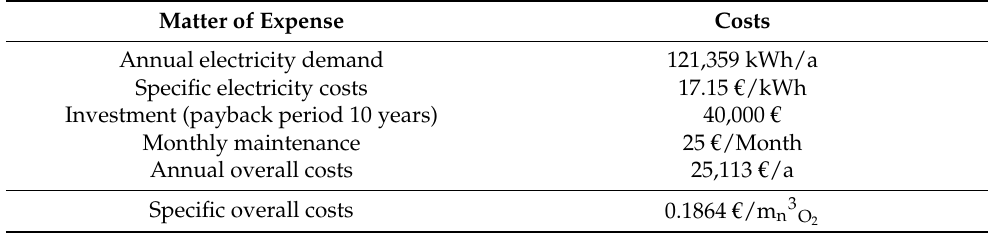
Table 7. Running costs for oxygen from